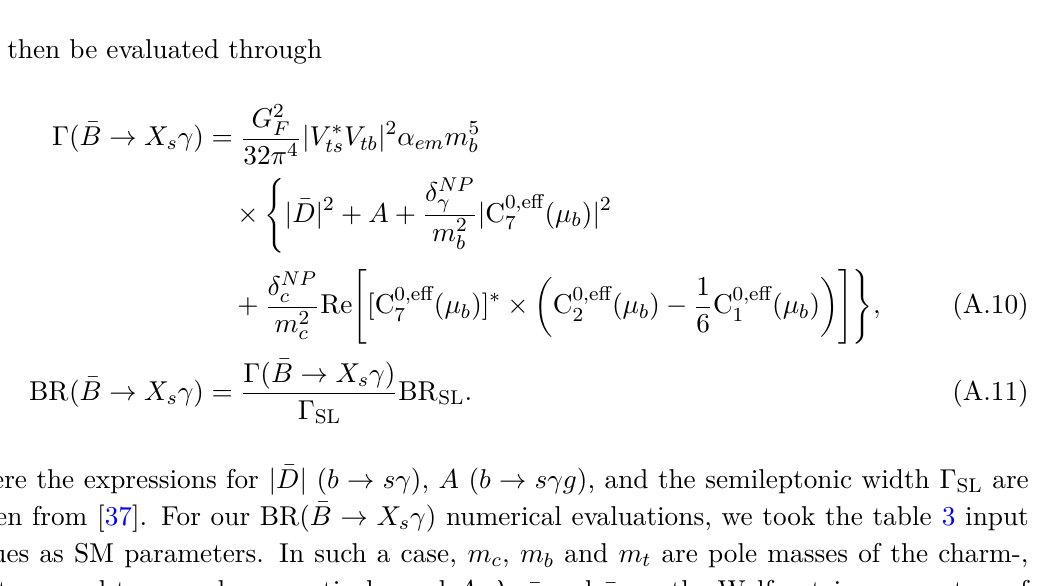
Table 3 . Input values for the SM parameters. The central value of ¯ B → X s γ used here is obtained from these. We refer to [37] for the choice of fermion masses. The Wolfenstein parameters of the CKM matrix are taken from ref.